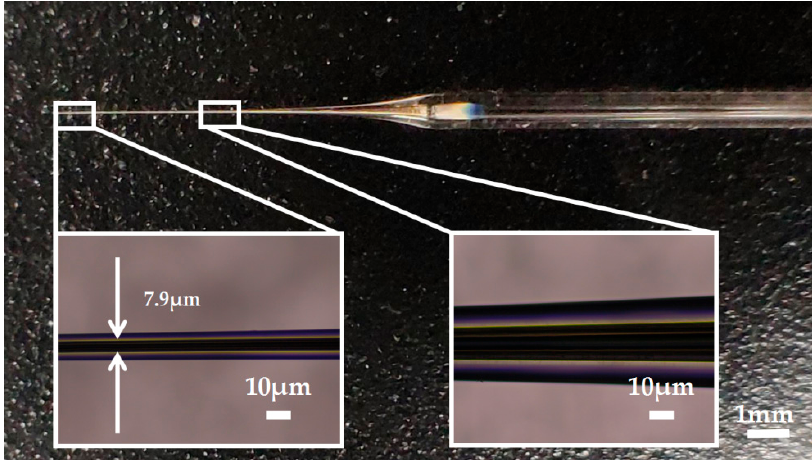
Figure 4. The picture of the Ag needle electrode.